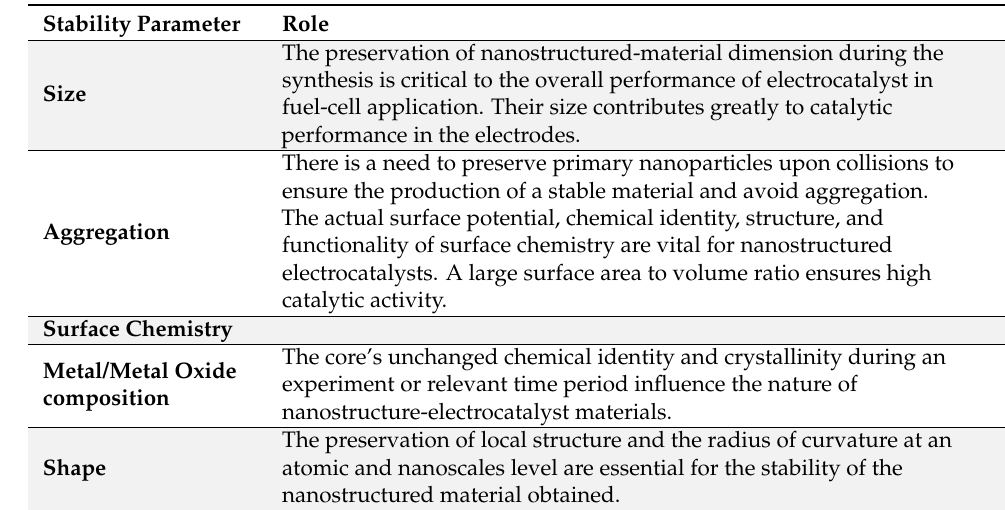
Table 6. Parameters that must be considered during the synthesis of nanostructured electrocata- lyst